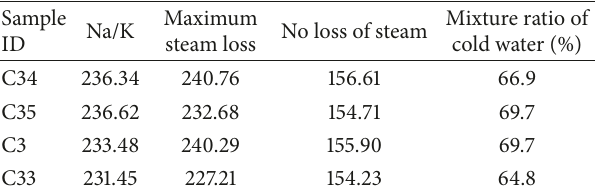
Table 4: Parameters of geothermal spring samples that experience mixing during ascent obtained from silica-enthalpy mixing models ( 𝑇 in ∘ C).